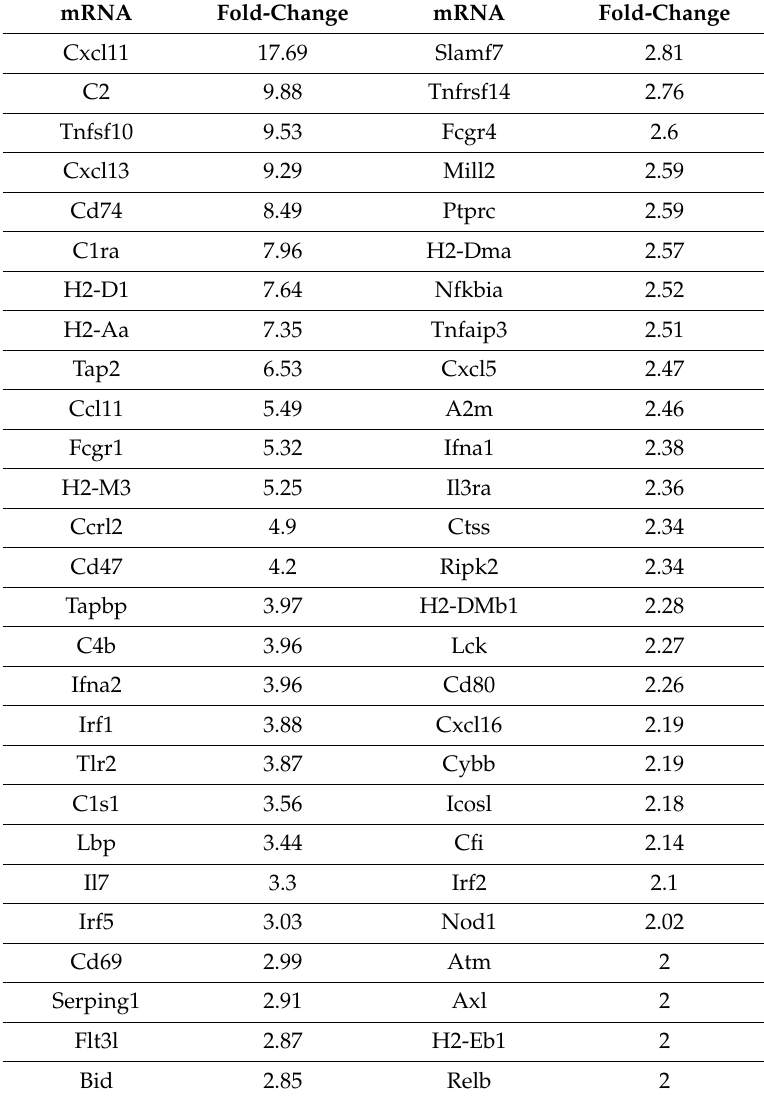
Table 7. Upregulated mRNAs in ZIKV-infected neurons at 48 h only.